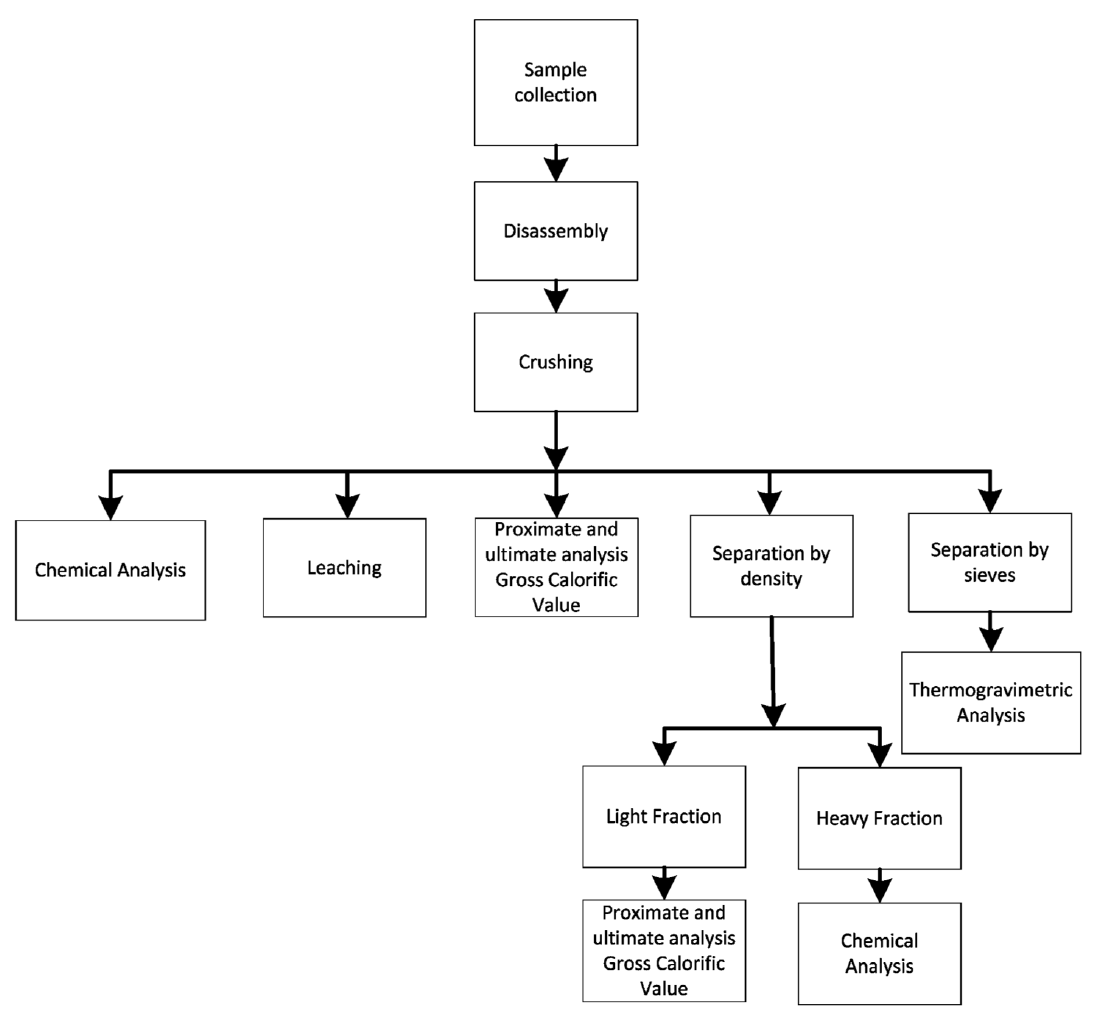
Figure 4. Steps involved in the characterization of discarded